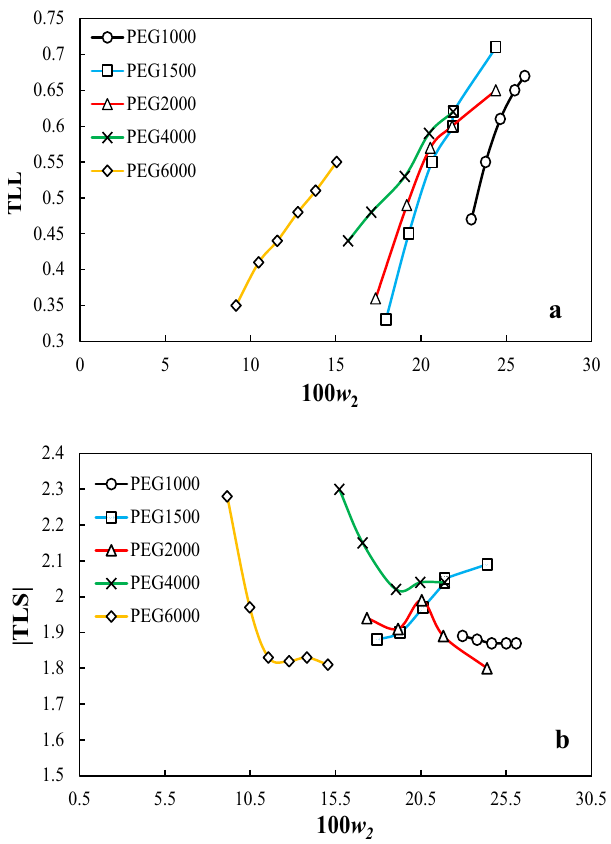
Figure 2. ( a ) The tie-line length ( TLL ) as a function of the mass fraction of the salt in the stock solution ( w 2 ); ( b ) the slope of the tie lines (|TLS|) as a function of the mass of the salt in the stock solution ( w 2 ) for PEG